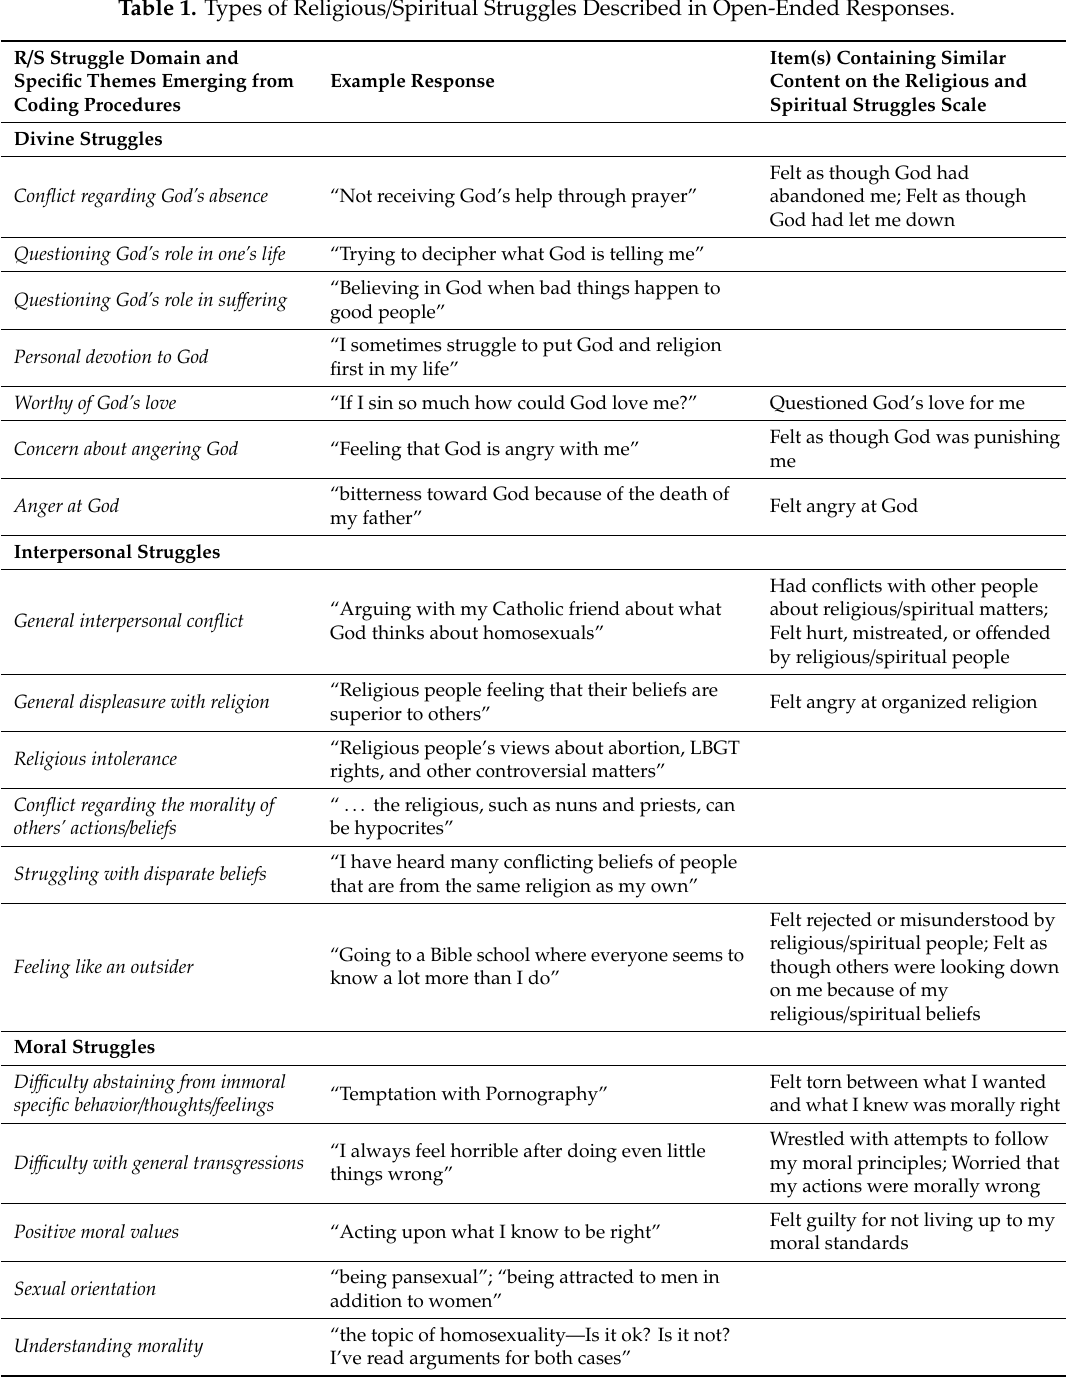
Table 1. Types of Religious / Spiritual Struggles Described in Open-Ended